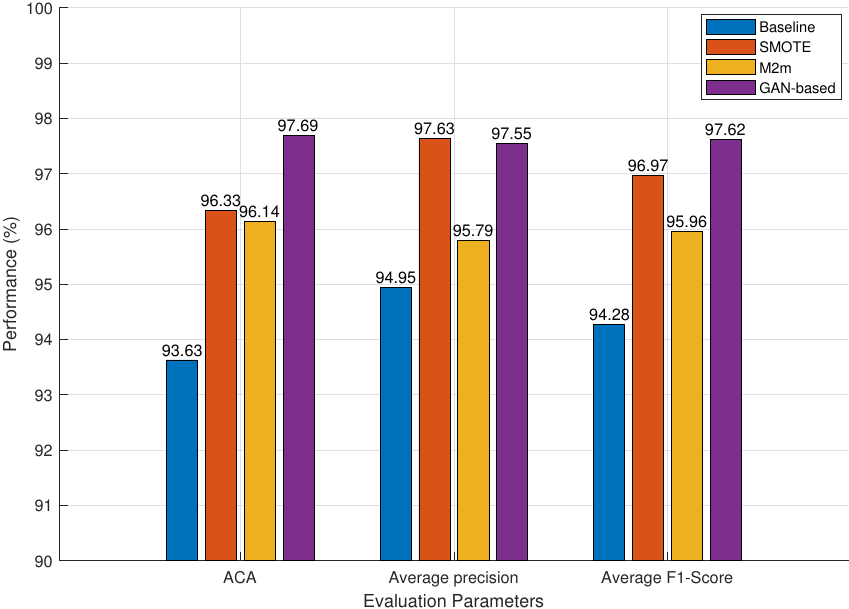
Figure 8. Metrics for evaluating different class imbalance approaches when CL + SH is applied as the preprocessed input and ResNet-50 used as the deep learning classifier (Average for 10-fold cross